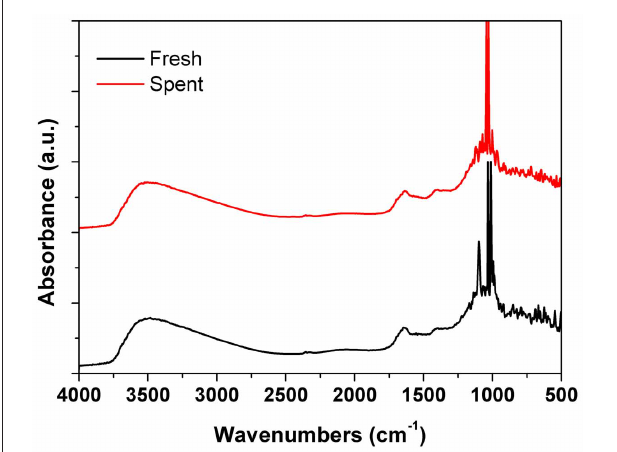
FIGURE 7 | DRIFTs spectra of the fresh and spent Pd/ γ -Al 2 O 3 catalyst. Spent catalyst was collected from inside the plasma